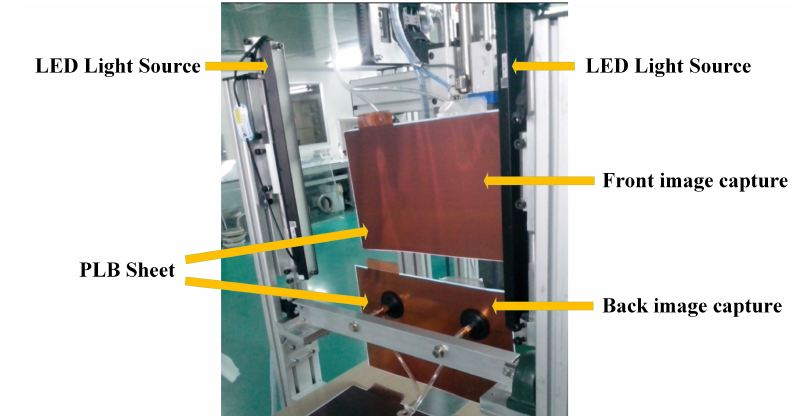
Figure 1. Image capture of PLB sheets.